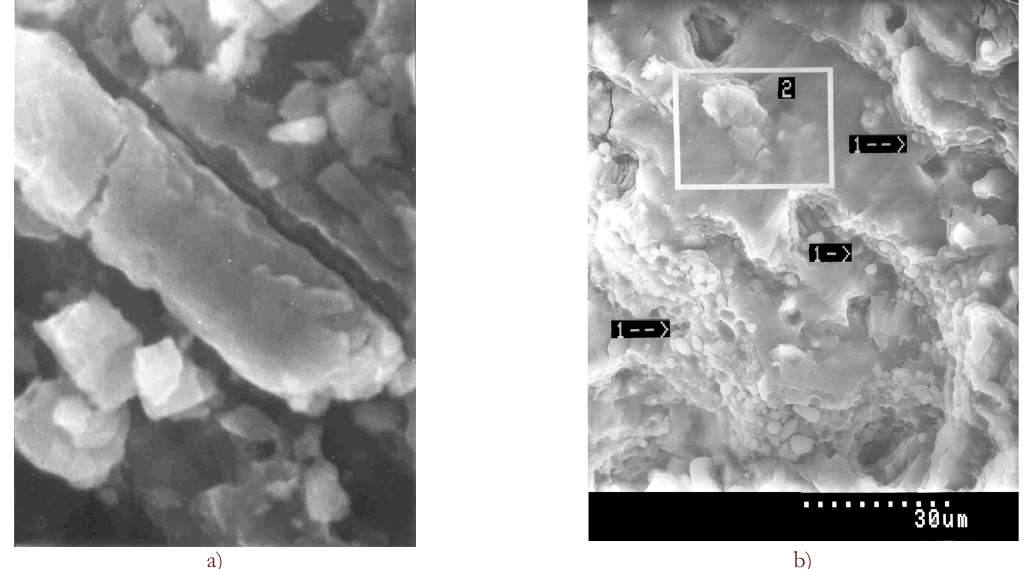
Figure 3: One of the cylindrical particles (a) with dislocation crack, and (b) the fracture surface (2) one of the mesotunnels with spherical particles (1) by the surfaces of collapsed crosspieces for a fatigued specimen of AK6 Al-based alloy tested under biaxial tension-compression.